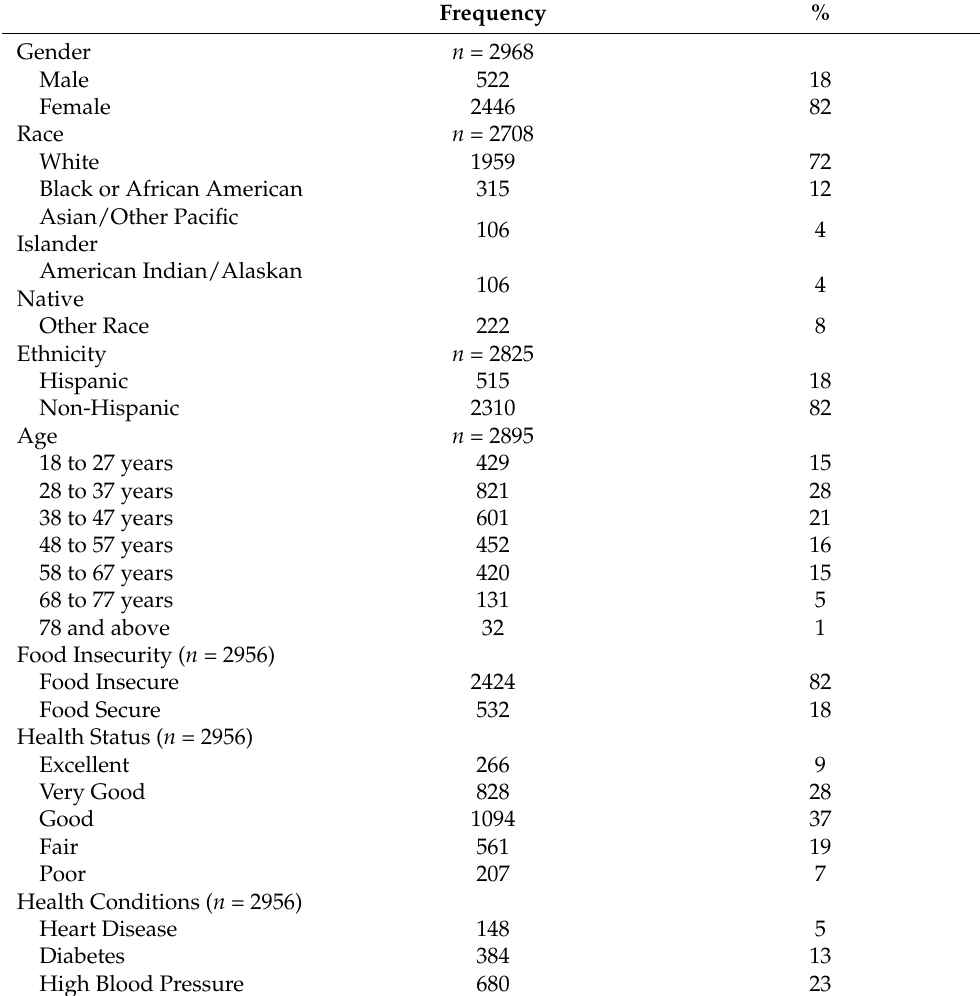
Table 1. Participant characteristics.